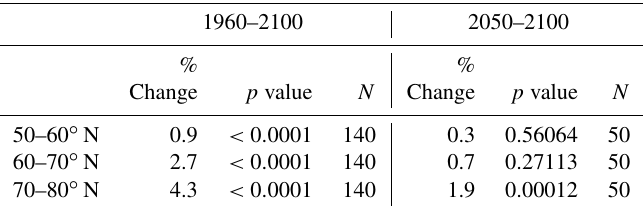
Table B1. Changes in zonal mean cloud cover between 50 and 80 ◦ N due to the evolution of GHGs (RCP 6.0), for the periods 1960–2100 and